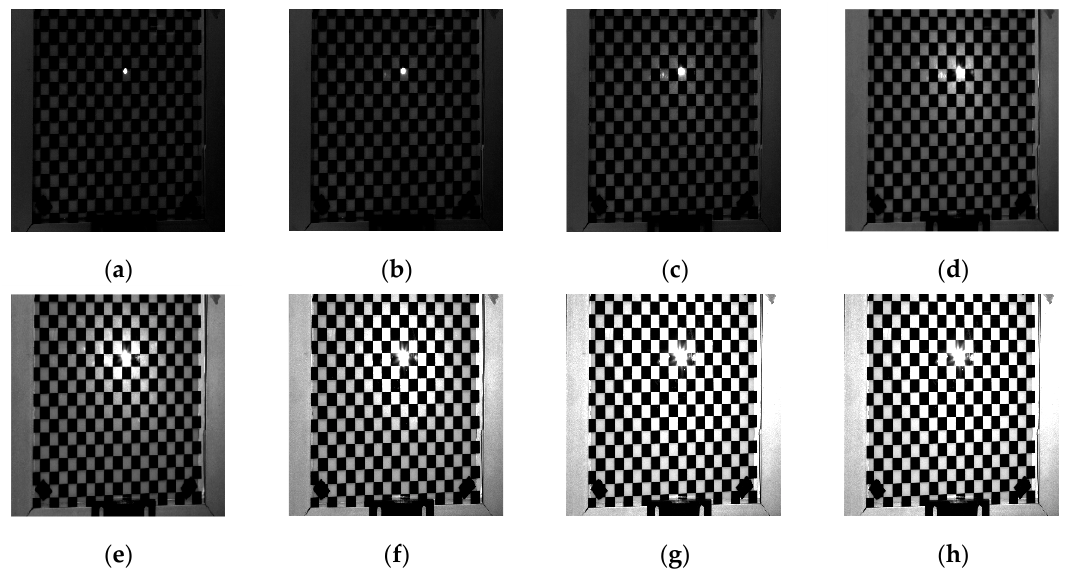
Figure 5. Checkerboard images captured by the right camera with different projection illumination. ( a ) With intensity of 0, ( b ) with intensity of 20, ( c ) with intensity of 40, ( d ) with intensity of 60, ( e ) with intensity of 80, ( f ) with intensity of 100, ( g ) with intensity of 120, ( h ) with intensity of 125.